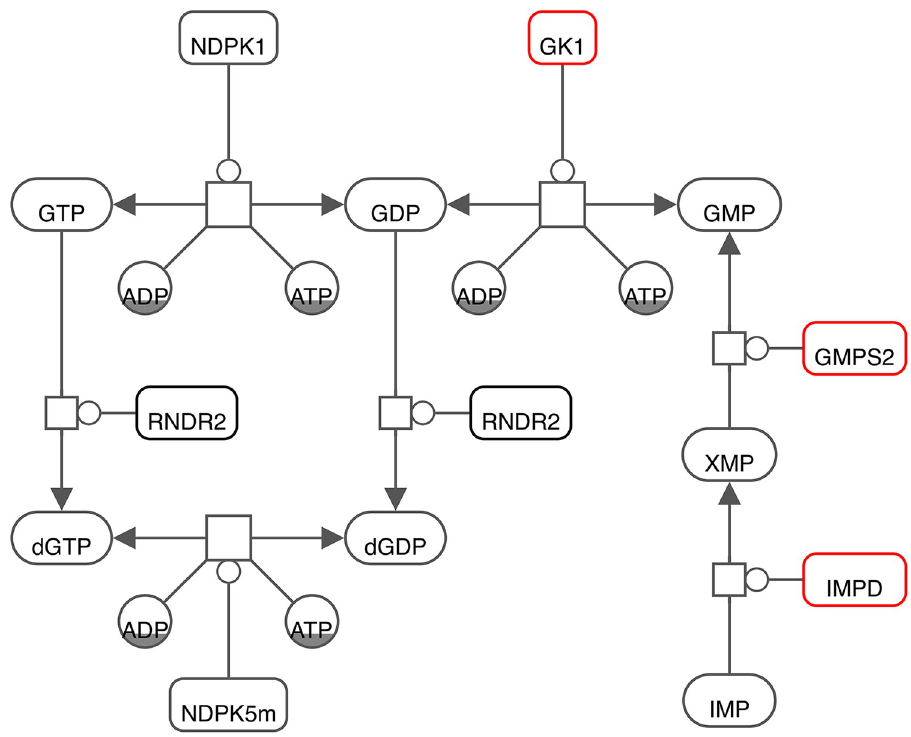
Fig 6. Graphical illustration of the interconnection between promising targets reported from the purine metabolism (red colored). To annotate reactions and metabolites, BiGG Identifiers were utilized.